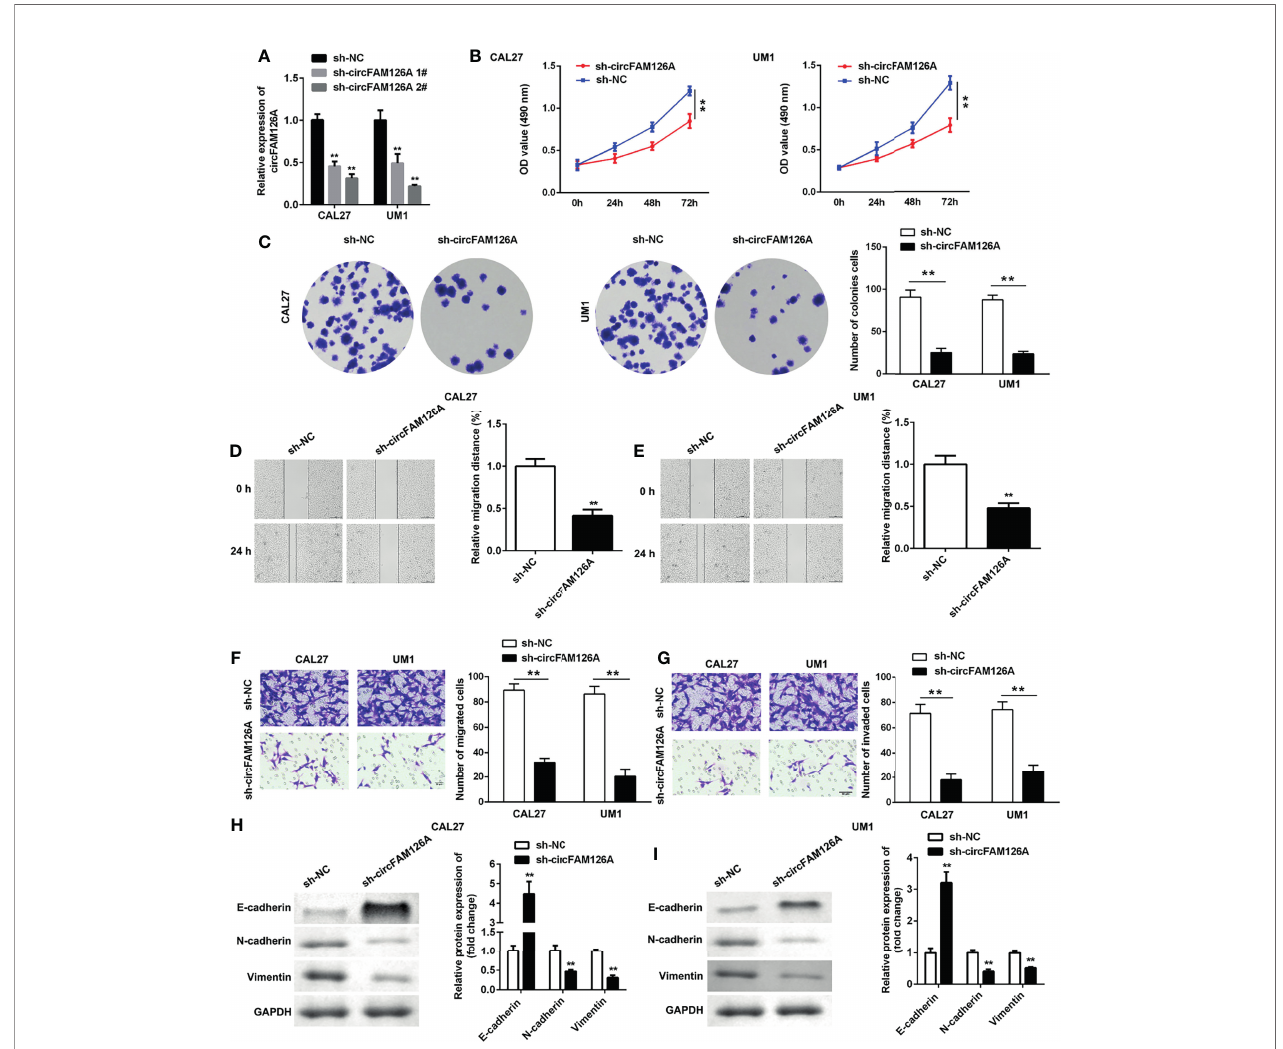
FIGURE 3 | circFAM126A shRNA inhibits proliferation, migration, and invasion of OSCC cells. (A) Expression of circFAM126A in OSCC cells detected by qRT-PCR. (B) Viability of CAL27 and UM1 cells determined by MTT assay. (C) Proliferation of OSCC cells detected by colony formation assay. (D, E) Migration detected using wound healing assay. (F, G) Migration and invasion of OSCC analyzed by transwell assay. (H, I) Protein expression determined using western blot. ** P